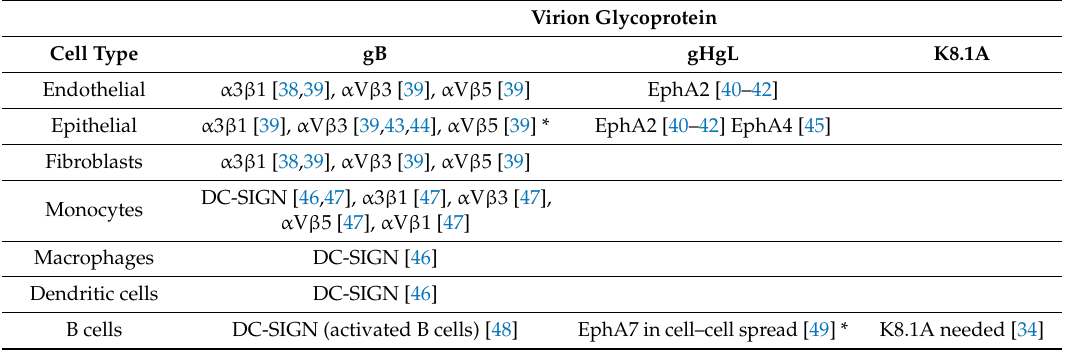
Figure 2. Steps of KSHV entry leading to capsid release. ( A ) KSHV glycoproteins in the virion and the host cell come into close proximity. ( B ) Multiple KSHV glycoproteins bind to heparan sulfate proteoglycans (HSPGs) containing molecules on the host cell plasma membrane. ( C ) Glycoproteins are now close enough that they specifically interact with receptors/signaling receptors on the host. Signaling receptors trigger endocytosis and virions are brought into the cell. ( D ) Signal transduction may occur between receptor binding molecules, intermediaries, and the fusion effector molecules. Fusion occurs once the virus reaches a low-pH compartment and may directly or indirectly trigger fusion glycoproteins. The capsid (green) is released into the cell cytosol. Table 1. Summary of KSHV glycoprotein interactions with receptors on pertinent cell types. In the left column, several KSHV-susceptible cell types are indicated with corresponding entry receptors indicated adjacently. The top row indicates glycoproteins known to interact with the indicated receptors, which are believed to be important for entry into the cross-referenced cell type. All the listed glycoproteins are known to bind HSPG with the addition of ORF4, which is not listed [33,35]. HSPG is present on the majority of cells with the exception of B cells. * Recent studies show that these interactions may not always be necessary [36,37]. EphA2: Ephrin receptor A2.